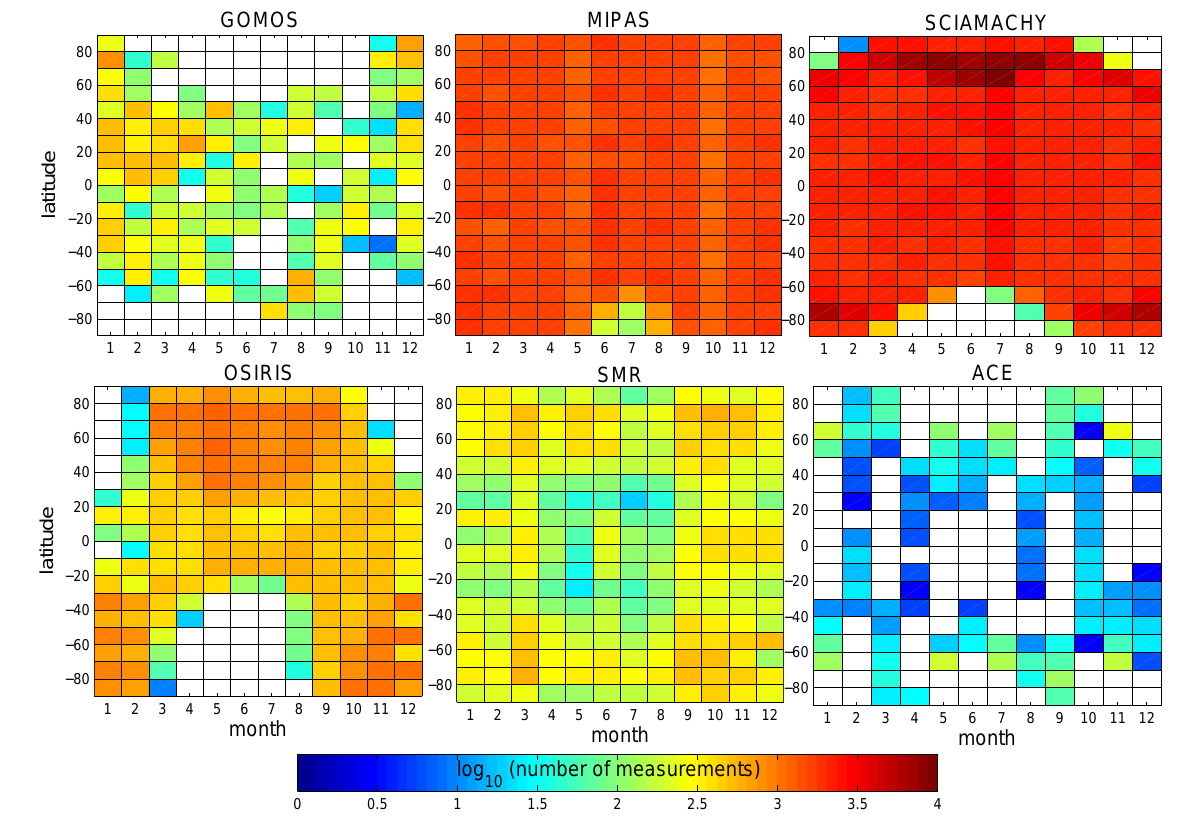
Figure 2. Logarithm of number of measurements in 10 ◦ latitude zones and in each month of year 2008.